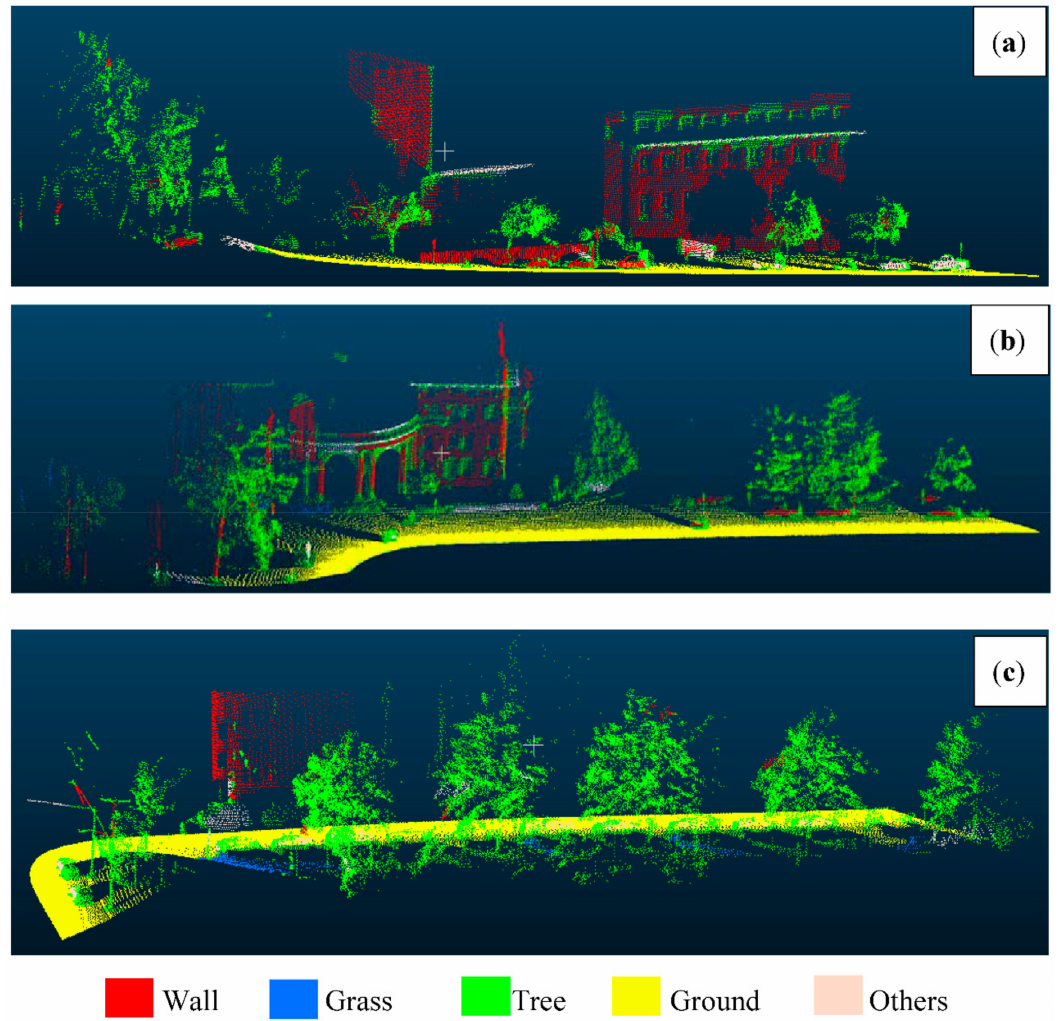
Figure 11. Classification results of Dataset3 (the testing set of the Oakland dataset) using the learned optimal scale, the optimal feature set, and a random forest: ( a ) Oakland test set I; ( b ) Oakland test set II; and ( c ) Oakland test set